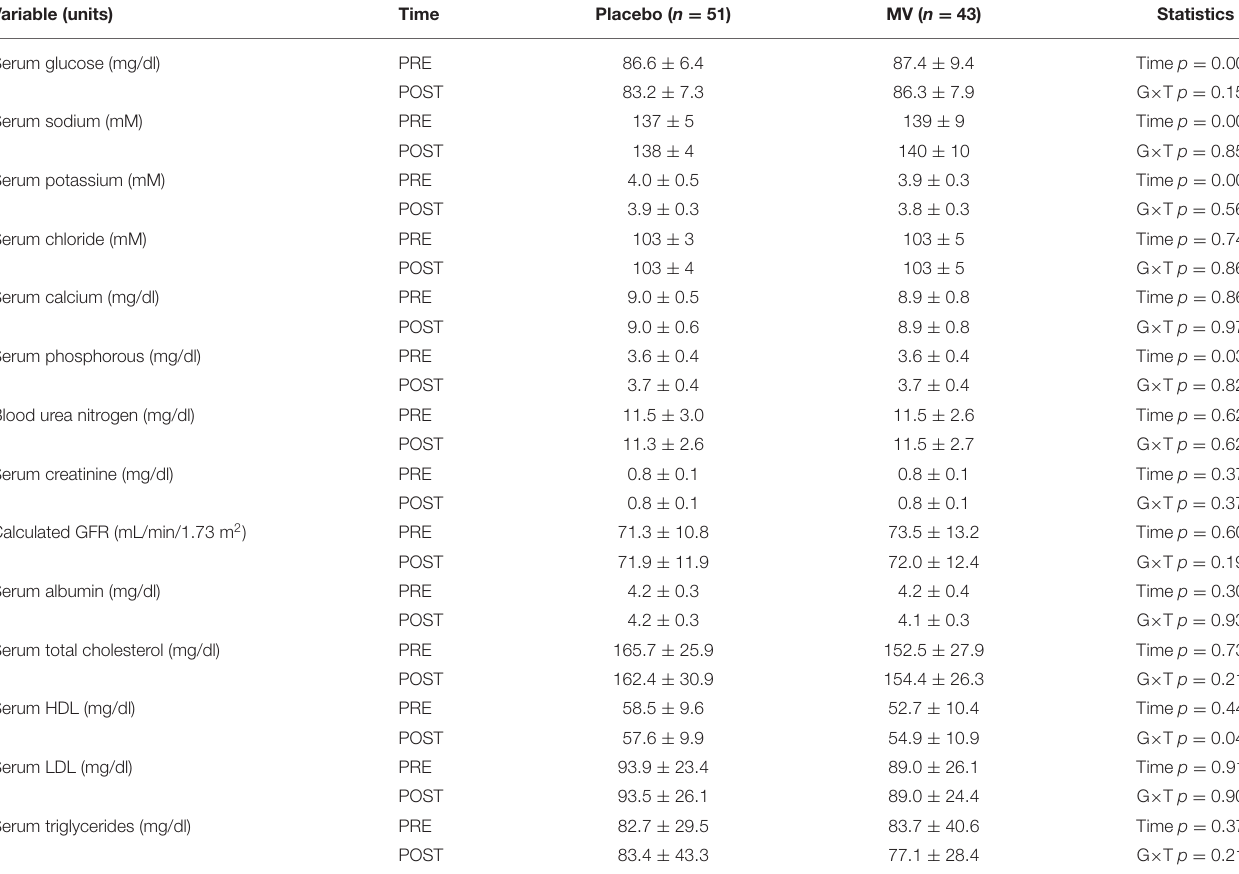
TABLE 4 | Serum markers of clinical safety. Variable